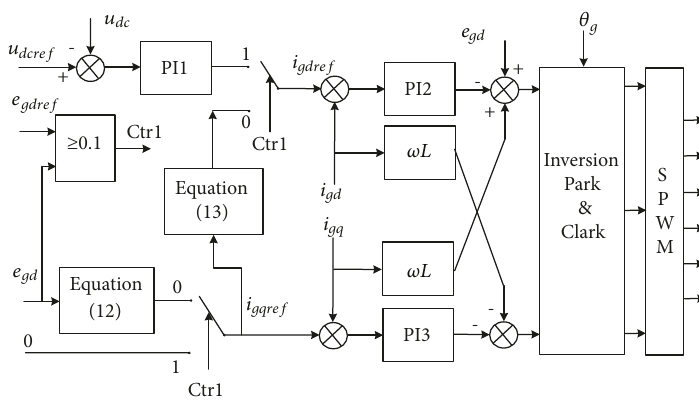
Figure 2: HVRT control scheme.